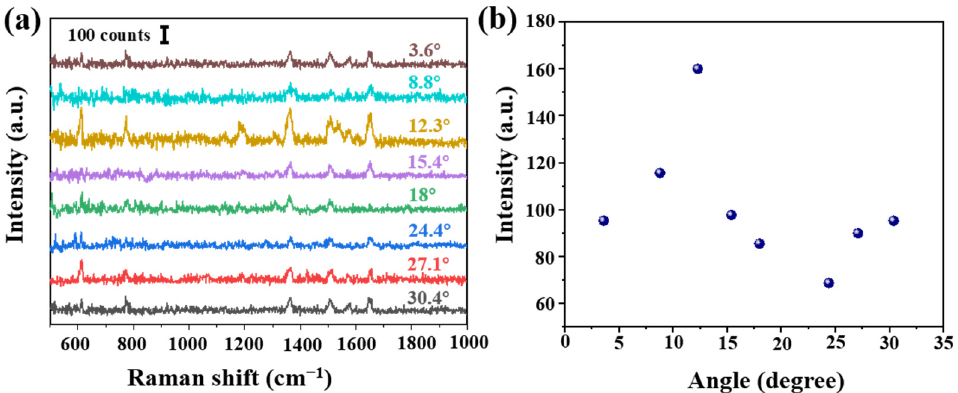
Figure 3. ( a ) Intensity of Raman spectra at different angles (R6G concentration of 10 − 6 mol/L) and ( b ) Raman intensity at 1364 cm − 1 at different angles. Note that each Raman spectrum is a result of averaged spectra data, in order to delete random error. The standard deviation is less than